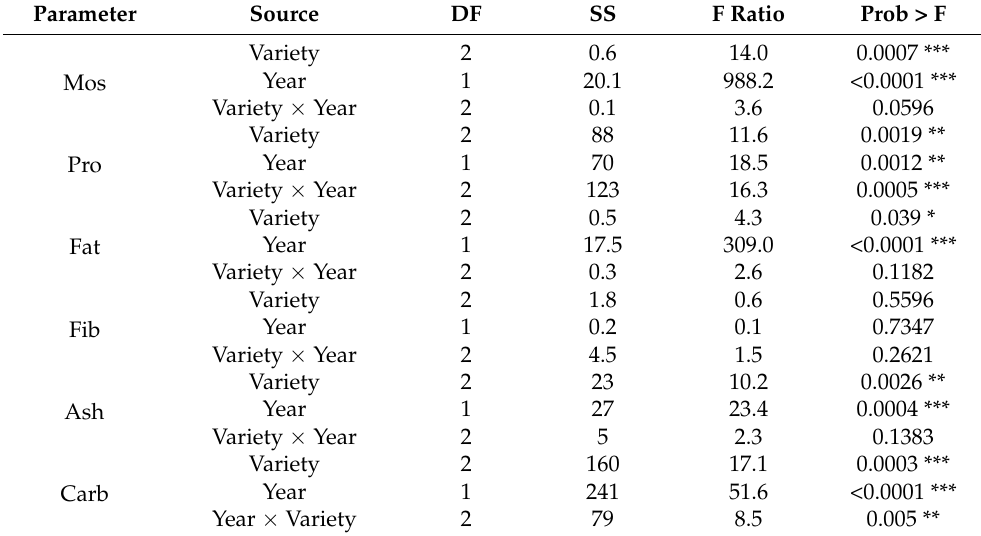
Table 4. The analysis of variance for moisture (Mos), protein (Pro), fat, fiber (Fib), ash, and carbohy- drate (Carb) for high tunnel-grown quinoa leafy greens in 2020, and 2021.